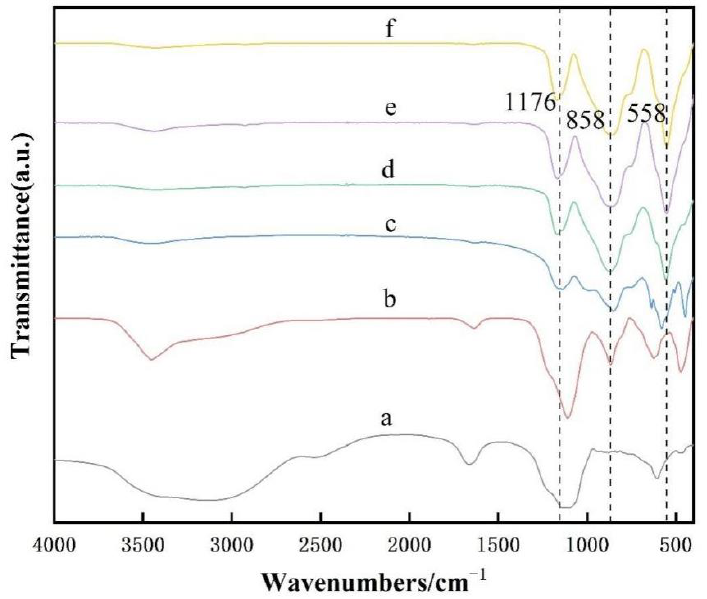
Figure 19. Infrared absorption spectra of mullite whiskers generated after calcination at 825 °C for 3 h with 10% sodium sulfate molten salt and 5% AlF 3 ·3H 2 O catalyst with different holding times, (a) 0.2 h, (b) 1 h, (c) 2 h, (d) 3 h, (e) 4 h, (f) 5